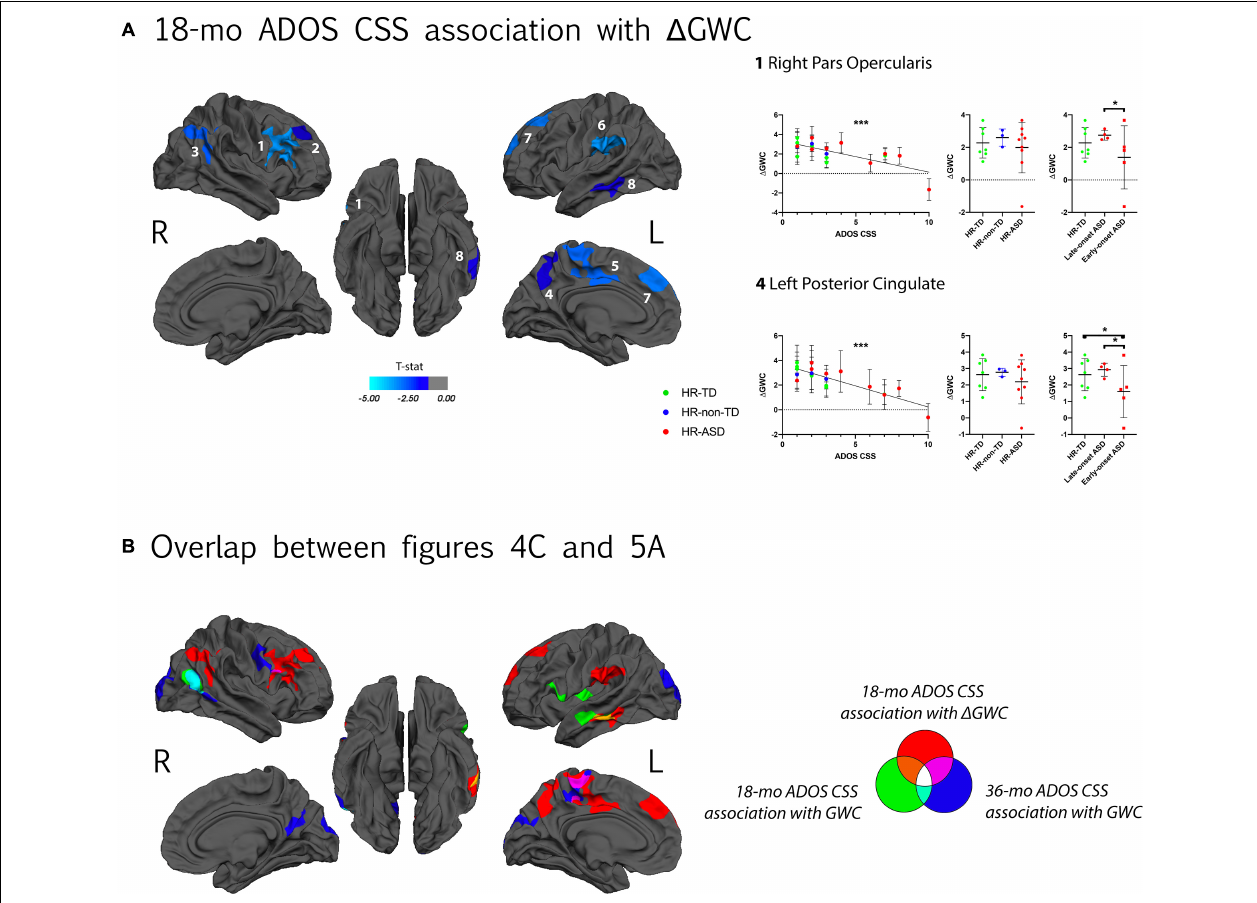
FIGURE 5 | (A) Association between GWC rate of change ( (cid:49) GWC) between 12 and 24 months of age and ADOS calibrated severity score (CSS) at 18 months of age. Only clusters with CWP < 0.05 after regression for age and correction for multiple comparisons are displayed. Color code corresponds to P -value of the vertex with maximal P -value (Pvm) of each cluster (see Table 2 ). In each hemisphere, clusters are listed in order of decreasing effect size (Pearson’s R, see Table 2 ). Individual (cid:49) GWC are displayed in function of ADOS CSS on the graph on the left. Only values for clusters with the greatest effect sizes are shown. Same individual values are further plotted in function of diagnostic outcome group (HR-TD, HR-non-TD and HR-ASD) in the middle graph. On the right, comparison between HR-TD and HR-ASD subgroups (LOA and EOA) are displayed. Similar graphs for all significant clusters are displayed in Supplementary Figure 4 . (B) Clusters displayed on (A) and clusters with a significant association between GWC at age 12–24 months and ADOS CSS at 18 months and 36 months of age ( Figure 4C ) displayed on a common template. Color code reflects which longitudinal GWC value (either mean GWC or (cid:49) GWC) and which ADOS CSS (either at 18 months or 36 months of age) were used in GLM. * p < 0.05, ** p < 0.01, and *** p <